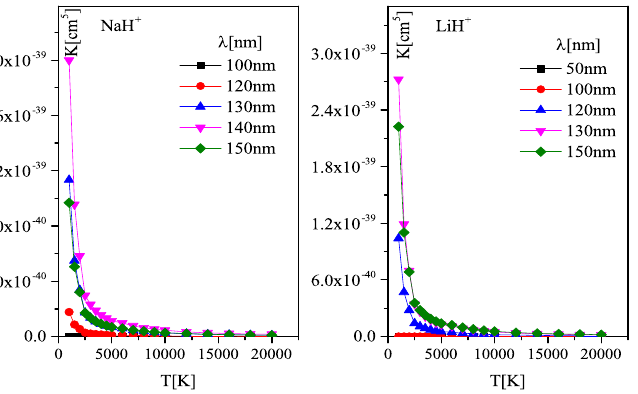
Figure 3. Left : A surface plot of the averaged cross-section σ ( λ , T ) for photodissociation of the Li + molecular-ion, as a function of λ and T ; Right : A surface plot of the averaged cross-section σ ( λ , T ) for photodissociation of the LiNa + molecular-ion, as a function of λ and T .